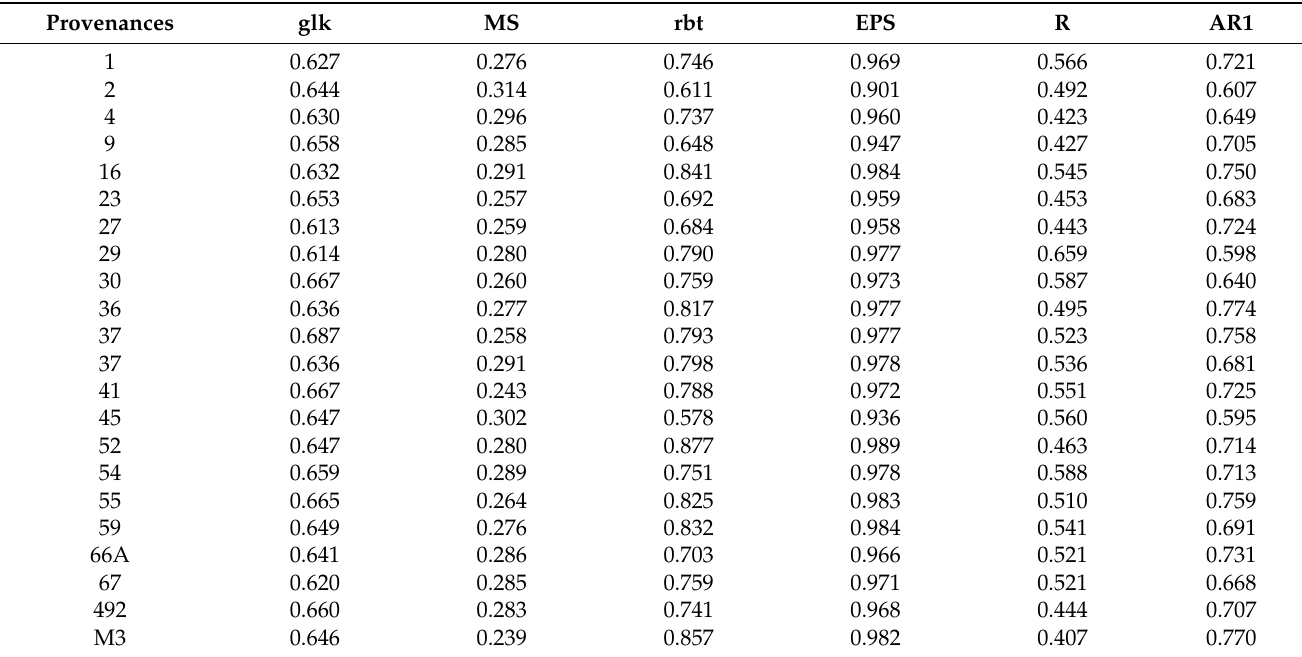
Table 3. Chronology statistics of Scots pine provenances, glk—gleichläufigkeit, MS—mean sensitivity, rbt—the average pairwise correlation between series, EPS—expressed population signal; R—mean inter-series correlation, AR1—first-order